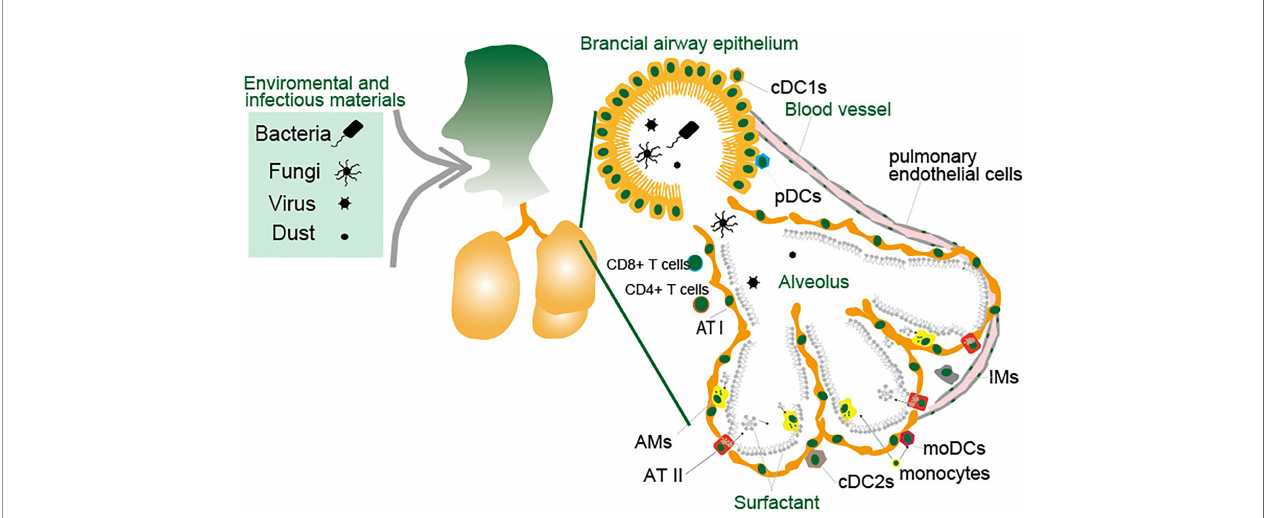
FIGURE 3 | Antigen presenting cells in the lung. The lungs are constantly exposed to environmental and infectious agents such as dust, viruses, fungi, and bacteria that invade the lungs upon breathing. The lungs are protected by various types of immune cells and epithelial cells. Lung DCs are largely divided into three major subsets and are broadly subdivided into pDCs, cDC1s and cDC2s. MACs in the lungs consist of two major populations: AMs and IMs. LECs consist of ATI and ATII cells in the alveoli, and the endothelial cells and other types of cells constituting the bronchial airway epithelium. Monocytes migrate to the lungs in response to in fl ammatory stimuli in a CCR2-dependent manner and these cells differentiate to moDCs or AMs. Small blood vessels allow oxygen to be extracted from the air into the blood, and carbon dioxide to be released from the blood into the air. The cells lining the inner surface of blood vessels are the pulmonary endothelial cells. These cells function as APCs that engulf pathogens through endocytosis or phagocytosis and present their peptides on major MHC-I or MHC-II protein complex to CD8 + or CD4 + T